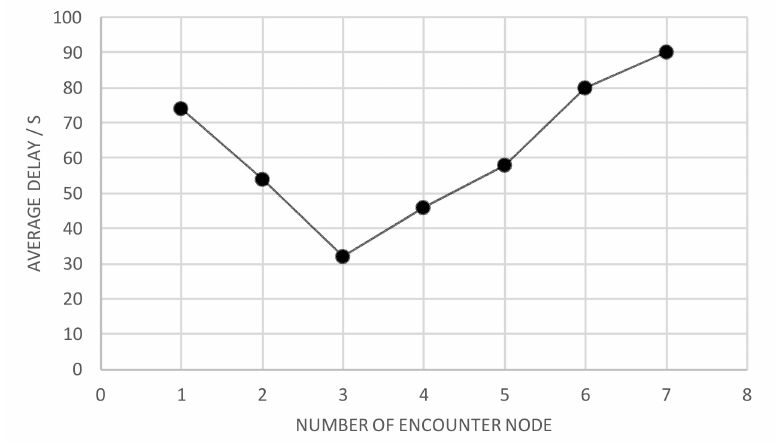
Figure 6. The relationship between average delay and encounter node.